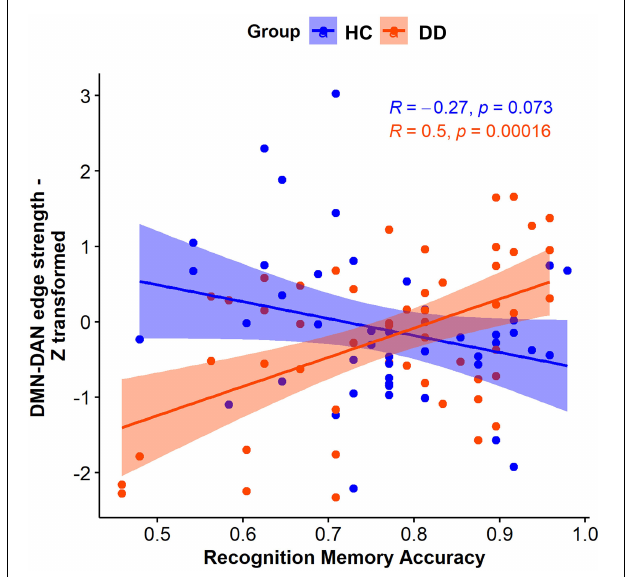
FIGURE 4 | The diagnosis-by-memory accuracy interaction effect on the edge strength between the DMN and DAN in individuals with DD and